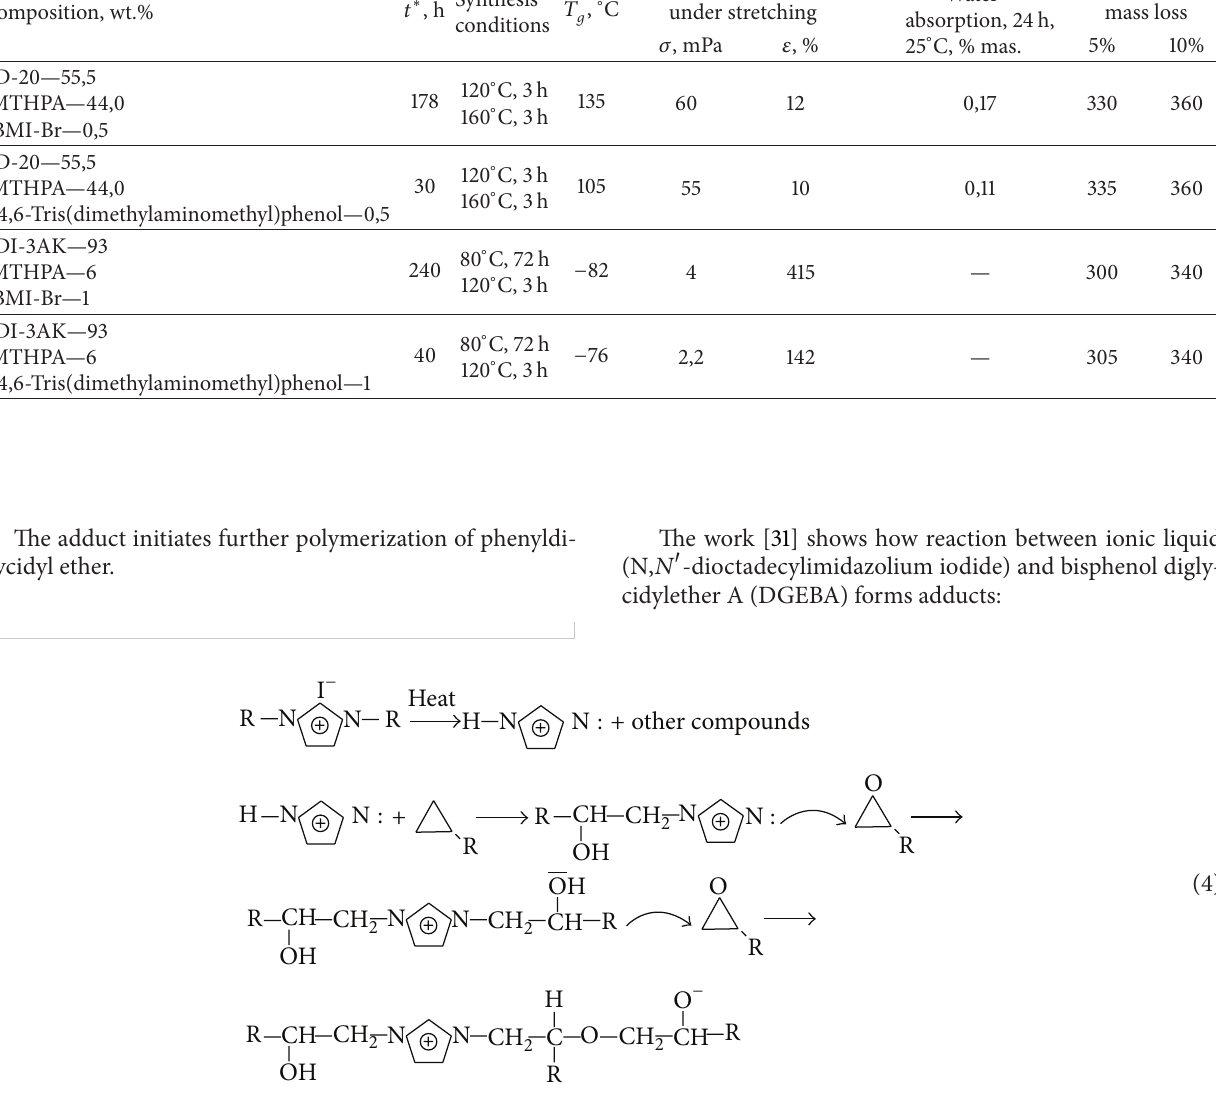
Table 2: Rheological, physic-mechanical, thermal properties of epoxy polymers. Composition,